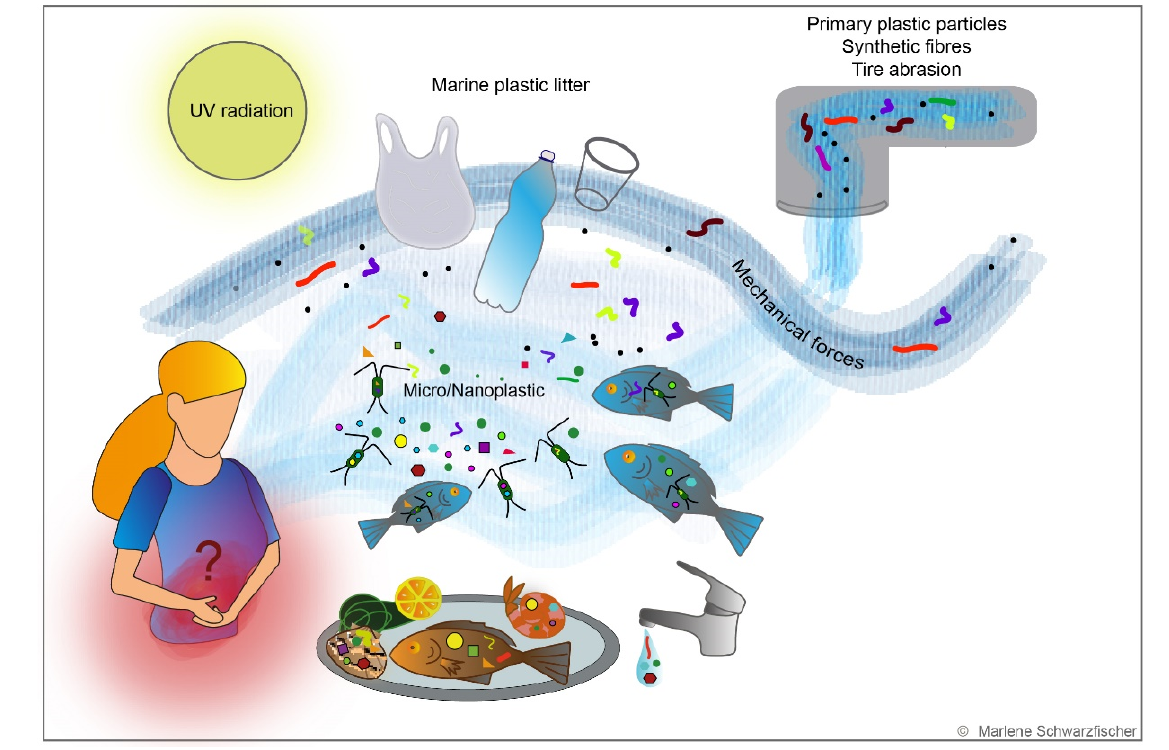
Figure 3. Nano- and microplastics in the environment. Several sources contribute to plastic contamination of fresh and salt water. Primary MP particles are designed for commercial use and encountered in cosmetic and pharmaceutical products. In contrast, secondary MP plastic particles progressively emerge with plastic fragmentation under the influence of environmental conditions. UV radiation, mechanical forces, biological degradation, and embrittlement result in the formation of NP and MP particles, which are ingested by marine zooplankton and consequently enter the marine and human food chain. Microplastic contamination was evidenced in seafood, drinking water, and other foodstuff. However, the impacts of ingested plastic particles on human health are not yet understood.